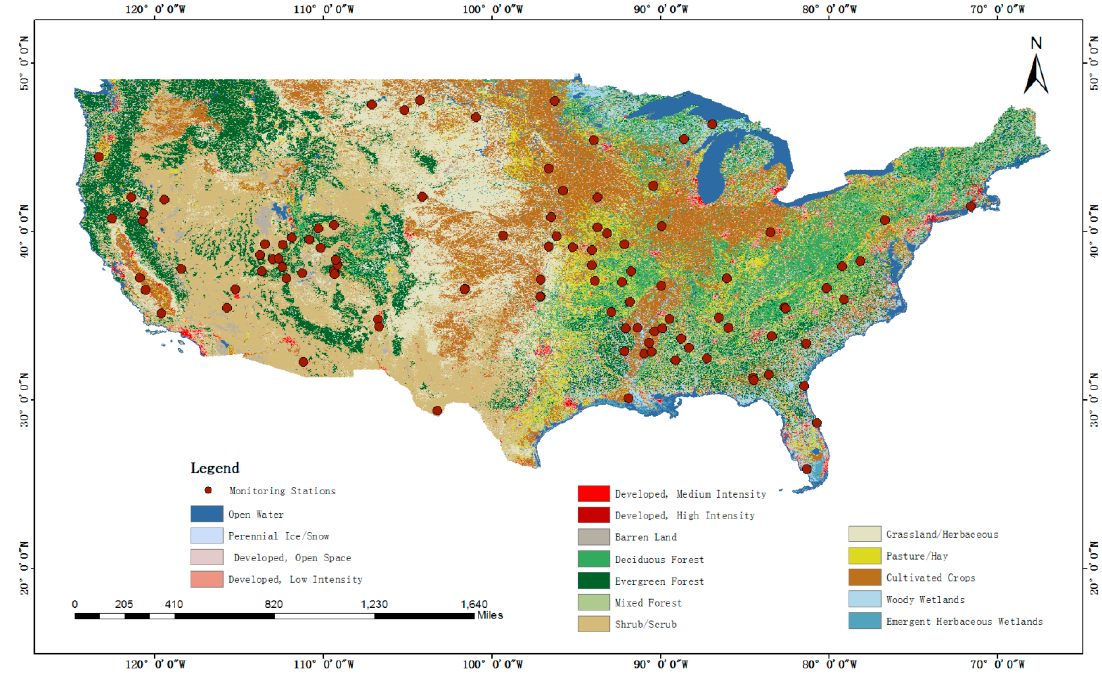
Figure 1. The 2011 National Land Cover Dataset (NLCD) land cover map and in-situ soil moisture observations sites. Table 1. The number of soil moisture sampling sites located in different spatial region and land cover types across the contiguous U.S. for acquiring monthly and daily average soil moisture